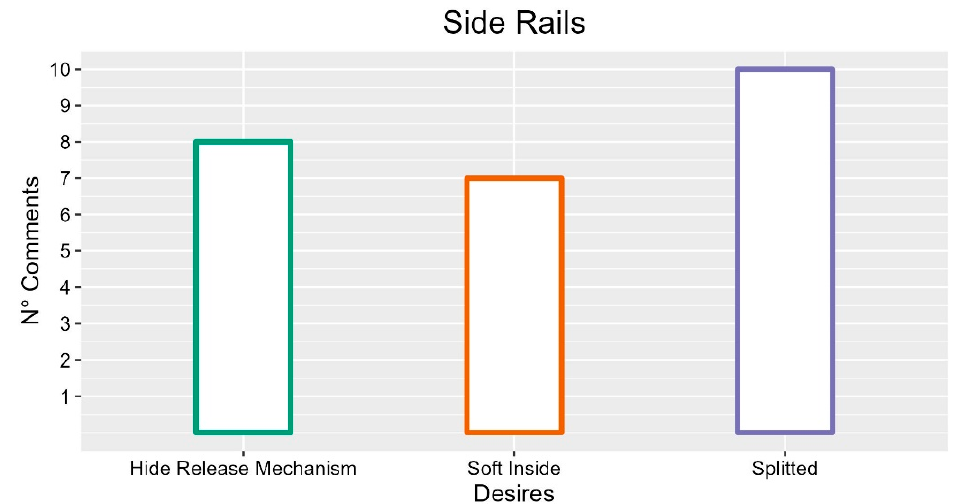
Figure 3. Graphical representation desires with more occurrences for the Side Rails theme.